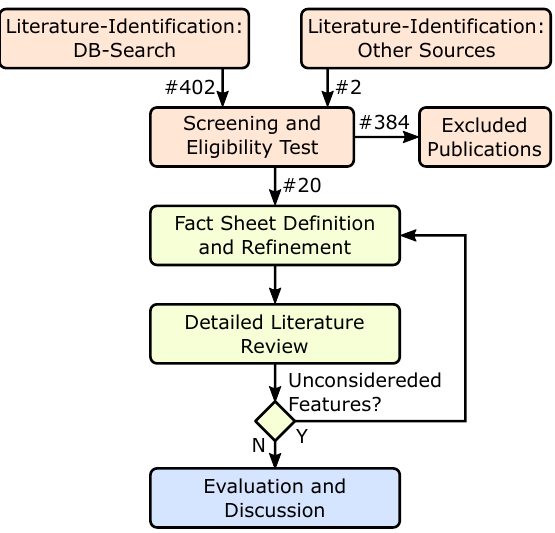
Figure 2. Review methodology workflow based on